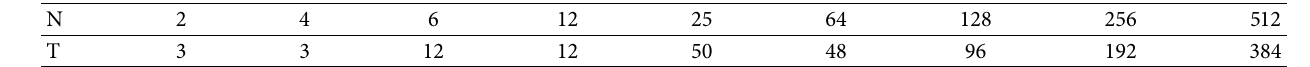
Figure 1: Comparison of histograms before and after Lena XOR encryption: (a) original histogram; (b) encrypted image Table 1: Arnold transformation period of images of different sizes.